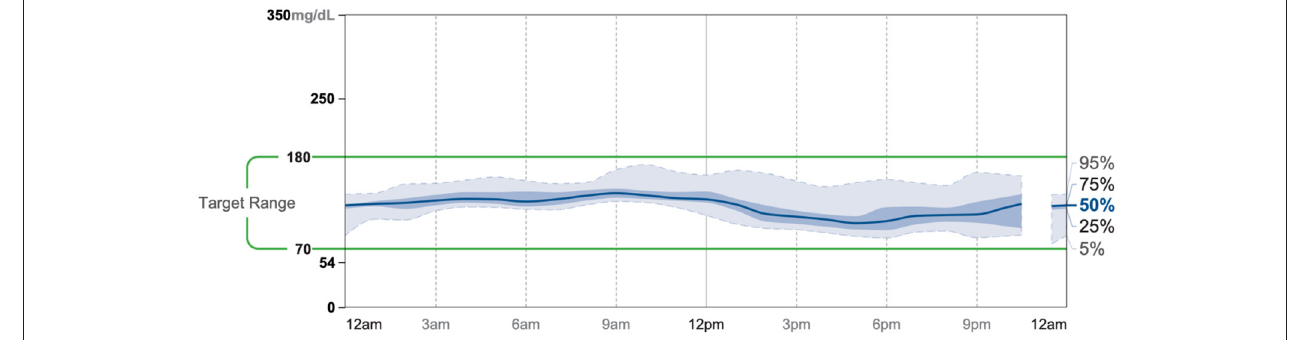
FIGURE 5 | AGP 11/25-12/8.